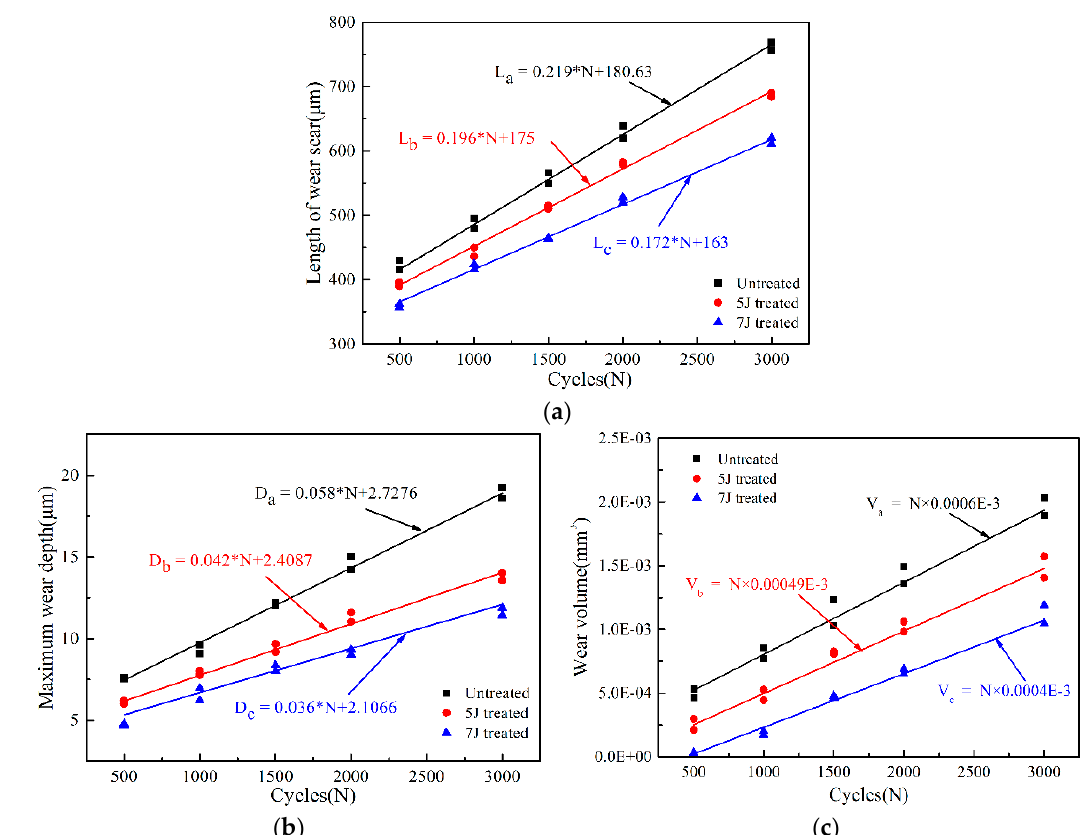
Figure 13. Changing rules of length, depth, and volume of the wear scars of three test samples. ( a ) Length of wear scars; ( b ) Wear depth of wear scars; ( c ) Volume of wear scars.